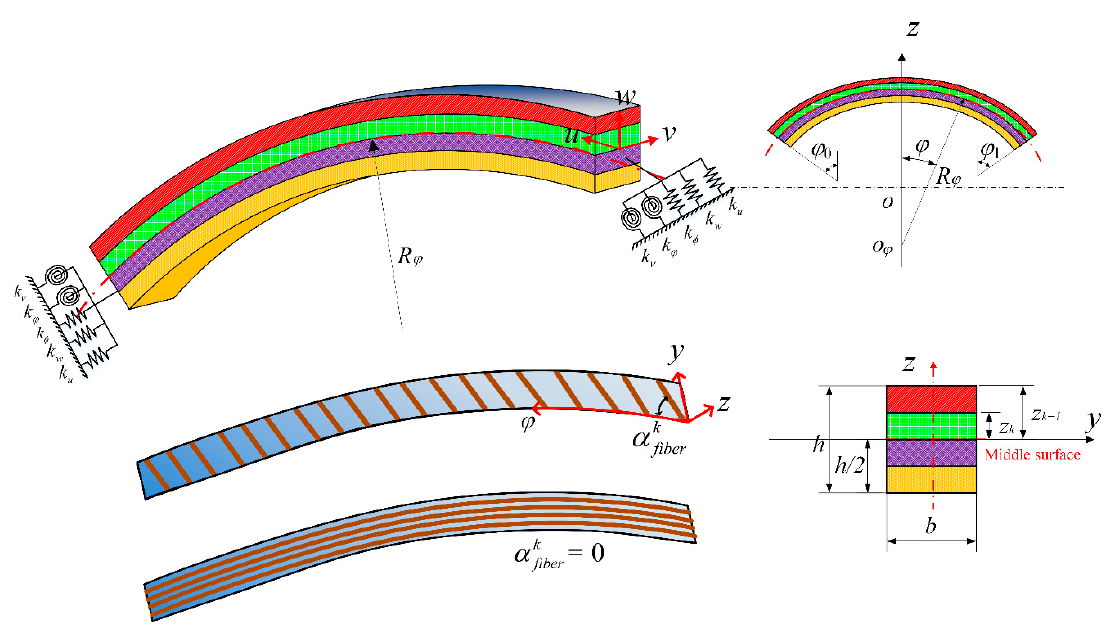
Figure 1. Schematic plot and geometric parameters of curved composite laminated beams. Materials 2020 , 13 , x FOR PEER REVIEW 5 of 23